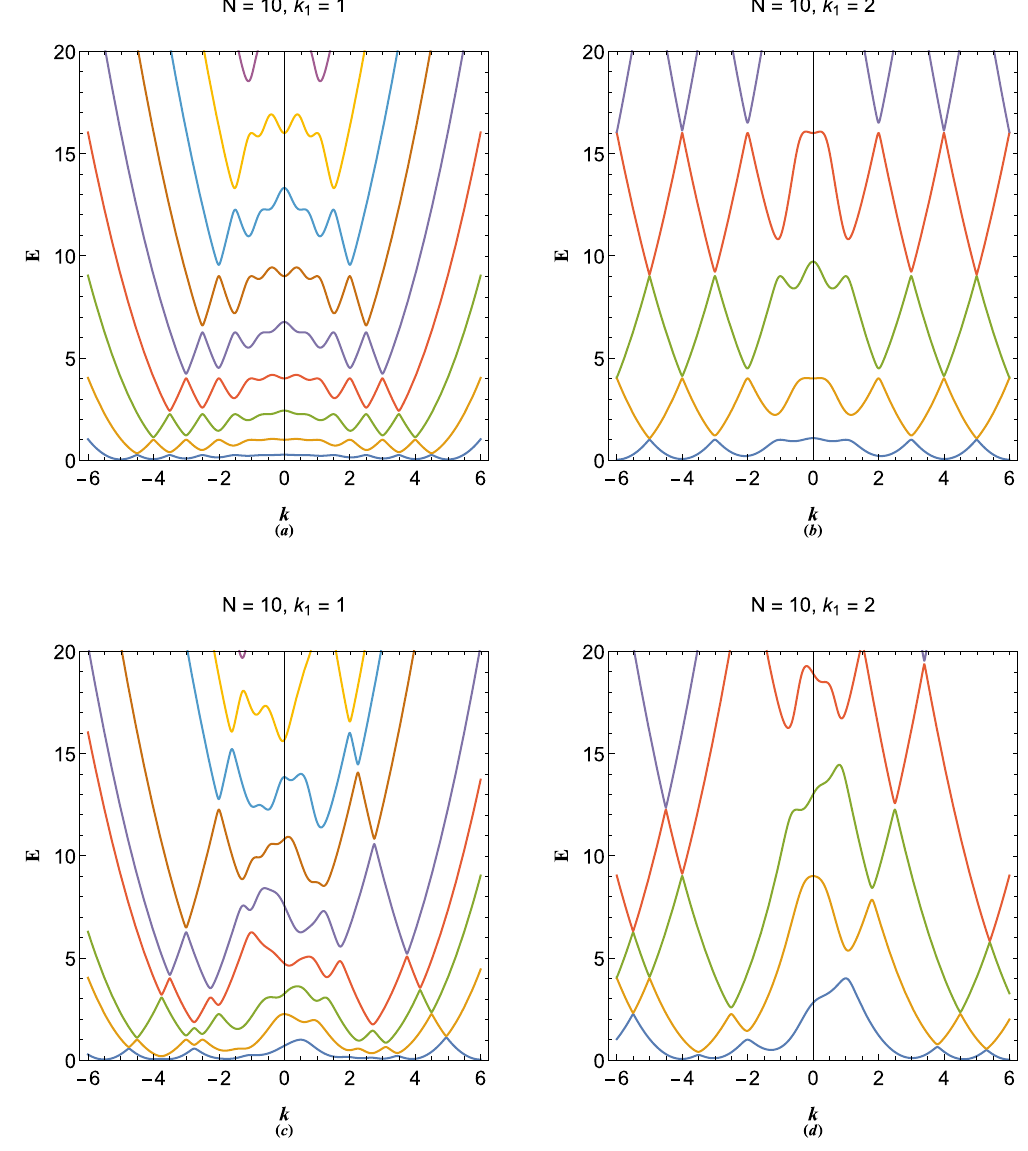
10 ), k N = Nk 1 , energy band structure of multistream electron gas = N = Nk 1 , energy band structure of multistream electron gas with 10 ), energy band structure of multistream electron gas with k 1 =